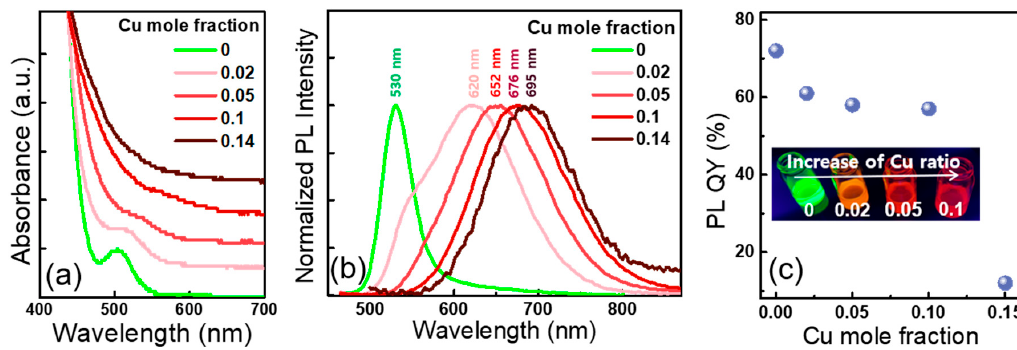
Figure 1. ( a ) Absorption; ( b ) normalized photoluminescence (PL) spectra; and ( c ) variation of PL QY of InP:Cu/ZnSe/ZnS QDs as a function of doping concentration of 0–0.14 Cu mole fraction. A fluorescent image of a series of QD samples under UV irradiation is shown in the inset of ( c ).